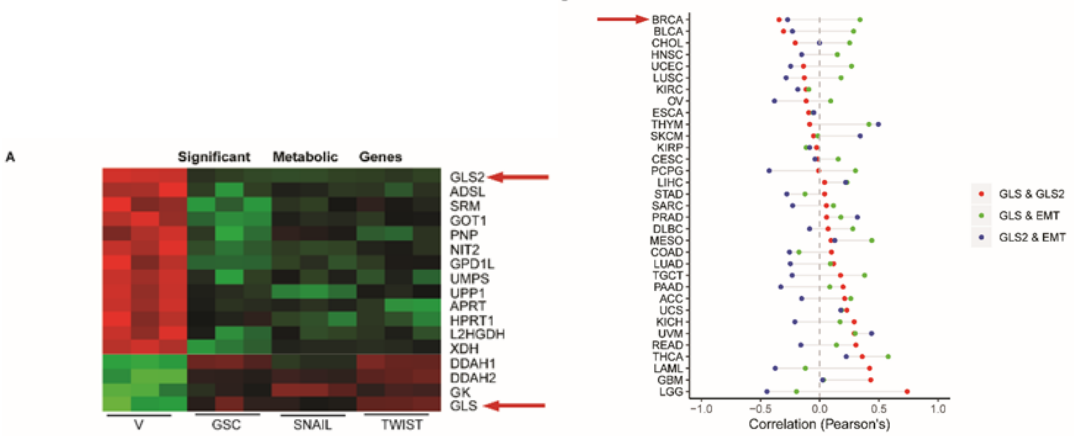
Figure 1. GLS2 is inversely correlated with epithelial to mesenchymal transition (EMT) in breast cancer patients. ( A ) Heatmap of mRNA expression of metabolism-associated genes obtained from a previously reported analysis [26] of HMLE cells treated with vector only (V) and in HMLE cells that express GSC, Snail, or Twist. GLS2 and GLS are indicated by arrows. ( B ) Plots of correlation between GLS and GLS2 (red circles), GLS and an EMT gene signature (green circles), and GLS2 and an EMT signature (blue circles) in difference cancer types. The breast cancer tumor (BRCA) relationship is indicated by the arrow.